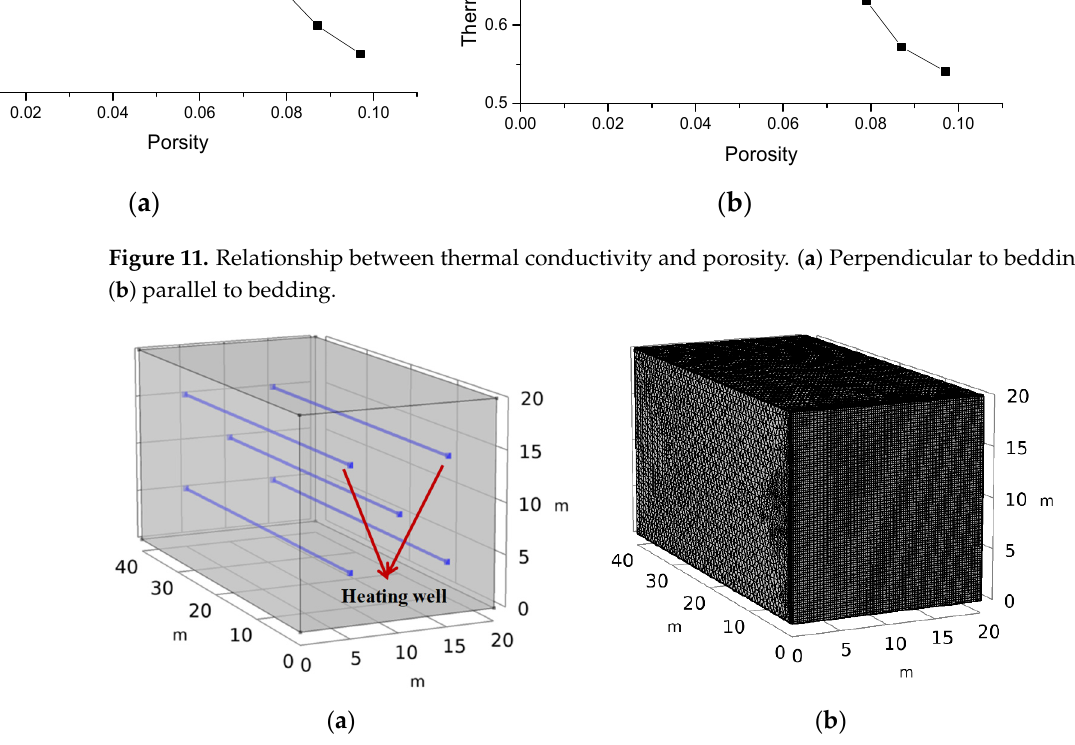
Figure 12. Geometric model and mesh. ( a ) Geometric model; ( b ) mesh.